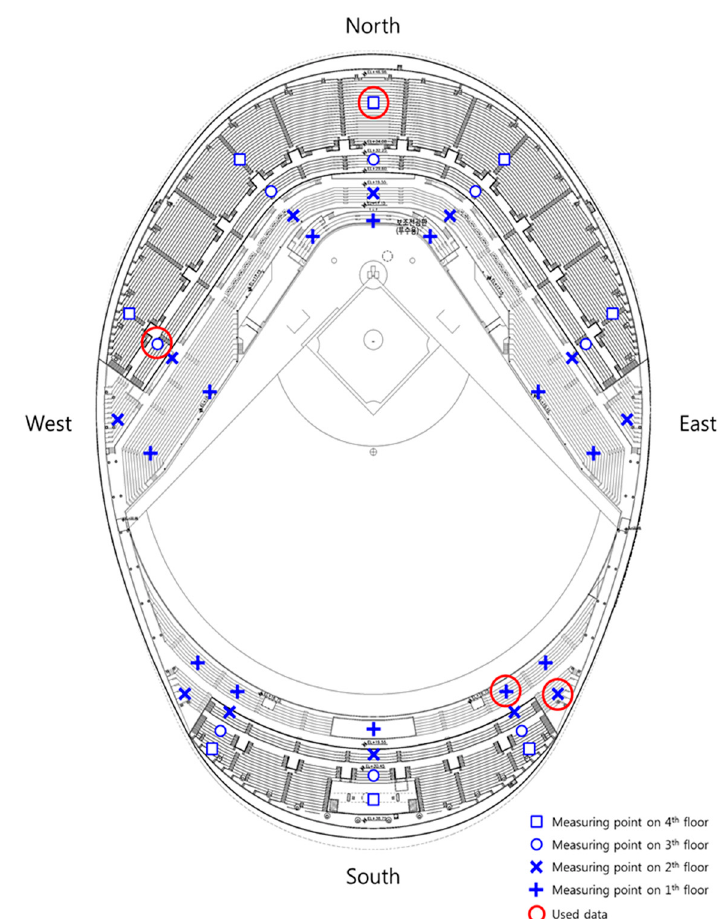
Figure 4. Measuring points for data collection on each floor.